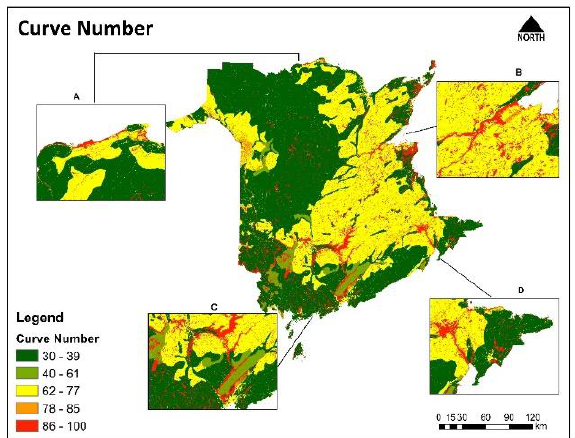
Figure A5. Curve Figure A5. Curve Number.